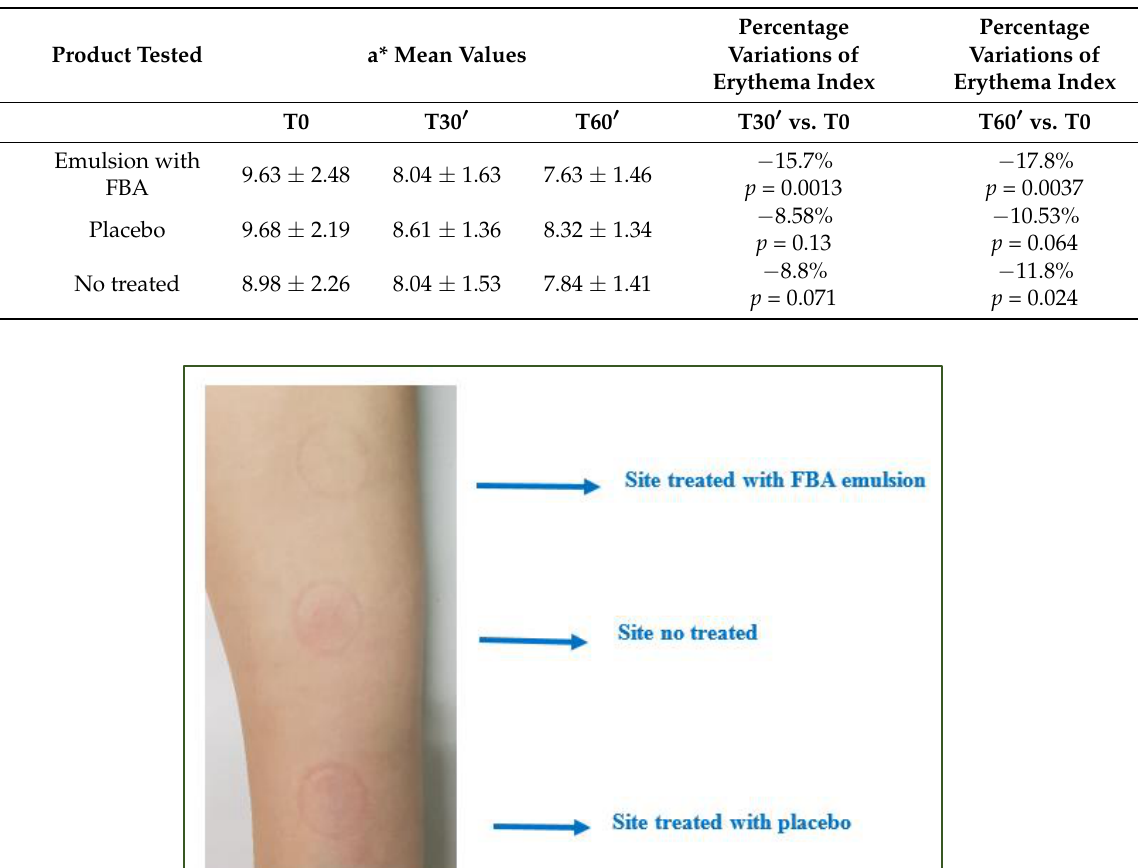
Table 3. Average of Erythema Index (a* mean values) at T0, T30 ’ and T60 ’ and average of decrease in erythema (%) after 30 ’ and 60 ’ for Emulsion with FBA (site A), Placebo (site P) and control site.